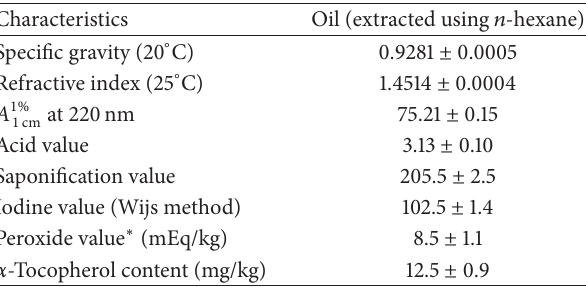
Table 1: Physical and chemical properties of fixed oil of Annona muricata L. seeds.